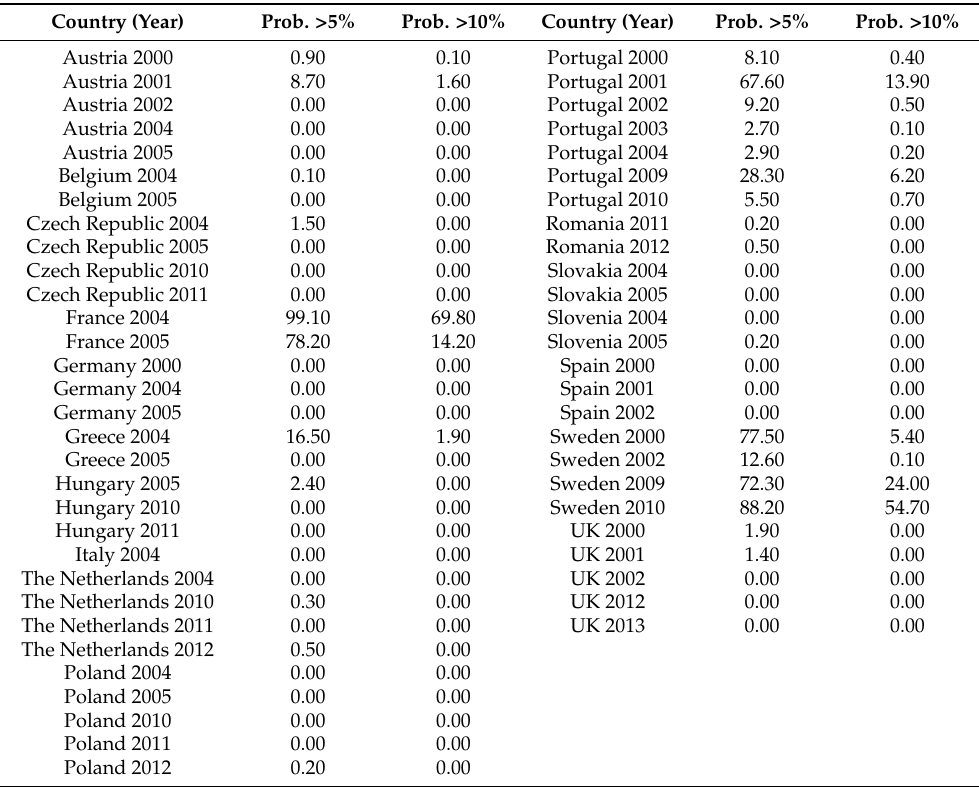
Table 2. Probability of rate of intercepting non-compliant food products being above 5% and 10% per country and